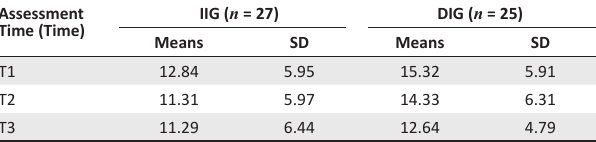
TABLE 2a: Means and standard deviations for the total score on the Penn State Worry Questionnaire for Children for the immediate intervention group ( n = 27) and delayed intervention group ( n = 25) from T1 to T4.